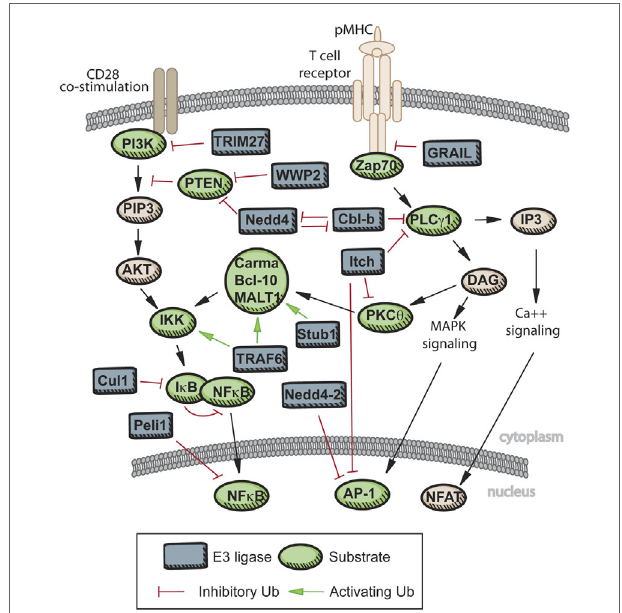
FiGURe 2 | Known roles of e3 ligase and DUBs in TCR signaling . Upon engagement of the TCR with peptide-MHC, several E3 ligases act to limit the strength of TCR signaling. GRAIL, CBL-B, and Itch are active in limiting proximal TCR signaling, and therefore enforcing T cell tolerance. Additional E3 ligases are activated with engagement of co-stimulatory molecules, and these E3s can promote activation of a T cell receiving signals through both the TCR and CD28 (Nedd4, WWP2), or limit signaling downstream of CD28 (TRIM27). Further downstream, activation of NF- κ B is dependent on K63 chain formation on a variety of scaffolding proteins, while activity of the AP-1 complex and nuclear localization of NFAT can be inhibited directly by E3 ligase activity or by repression further